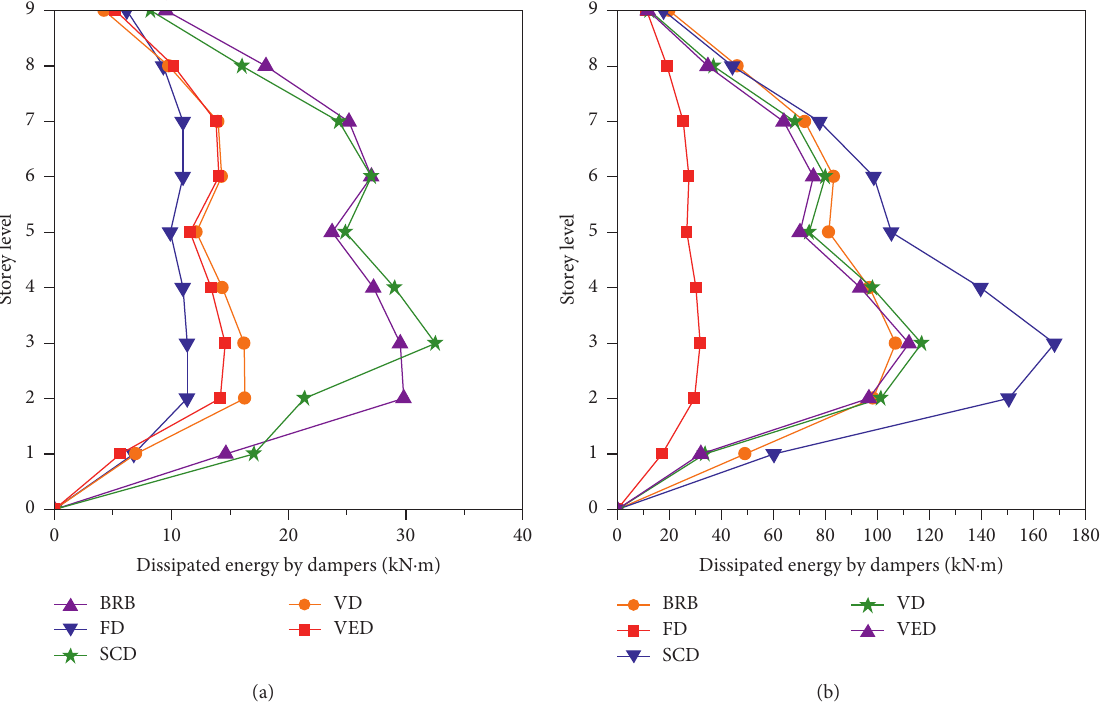
Figure 12: Dissipated energy by dampers on each floor. (a) The OE of CHY010. (b) The OE of